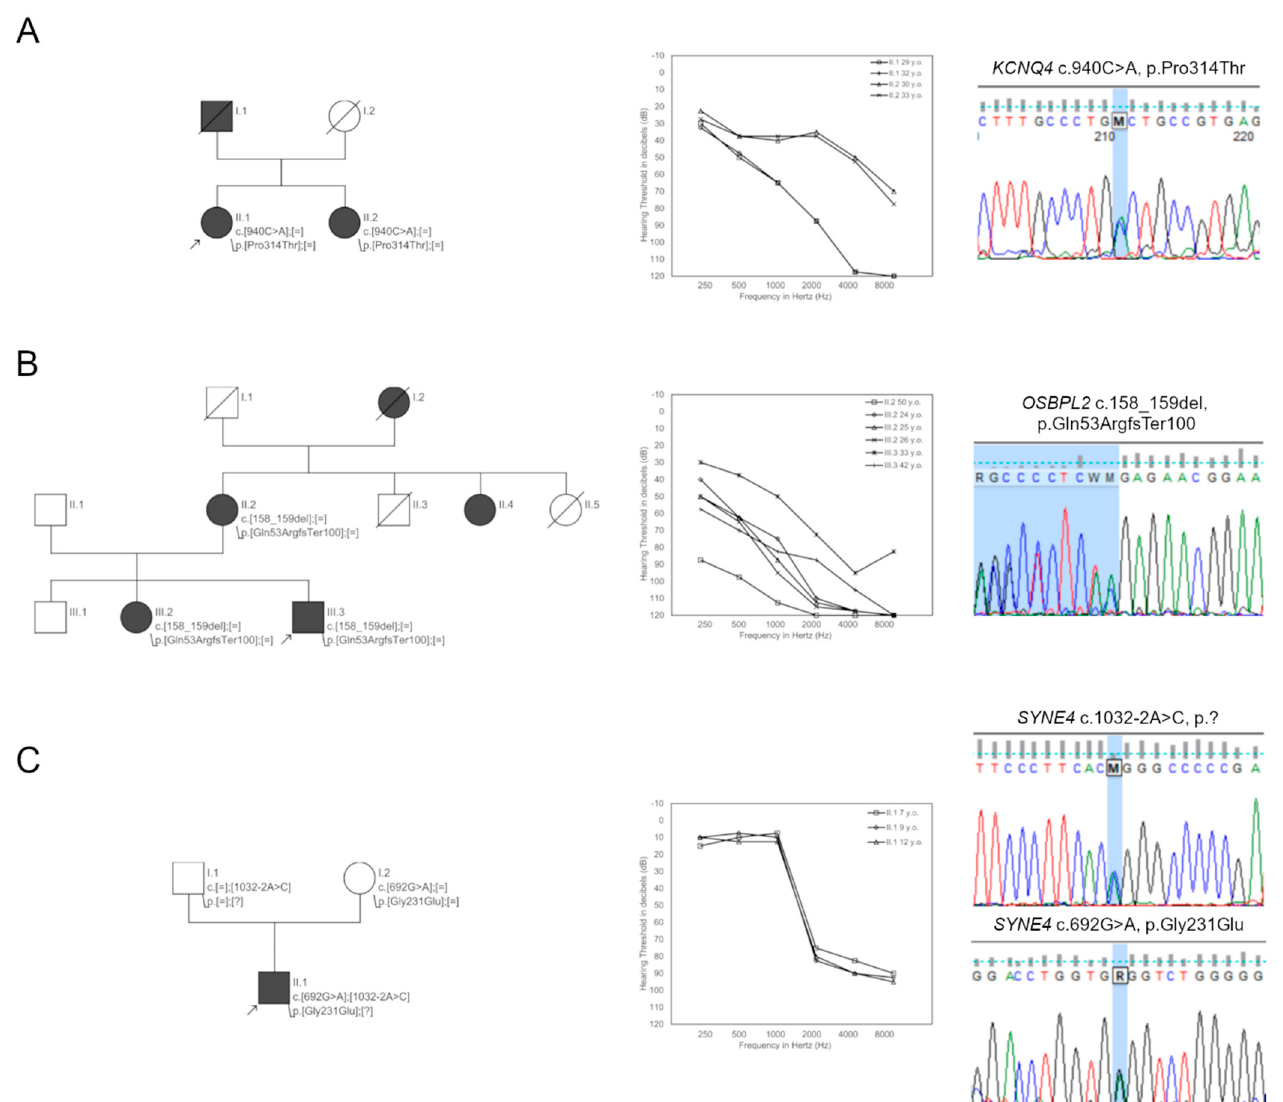
Figure 2. Selected genetic and audiometric data of PDT-EC patients. Families with causative variants in the KCNQ4 gene ( A ), in the OSBPL2 gene ( B ), and in the SYNE4 gene ( C ).